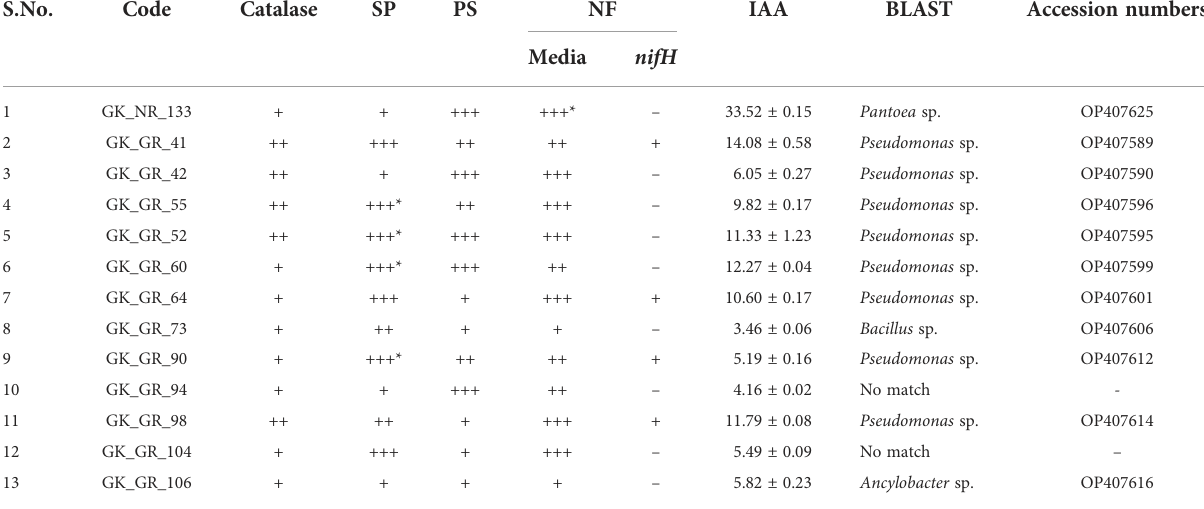
TABLE 4 List of bacterial isolates that tested positive for all the PGP traits. S.No.